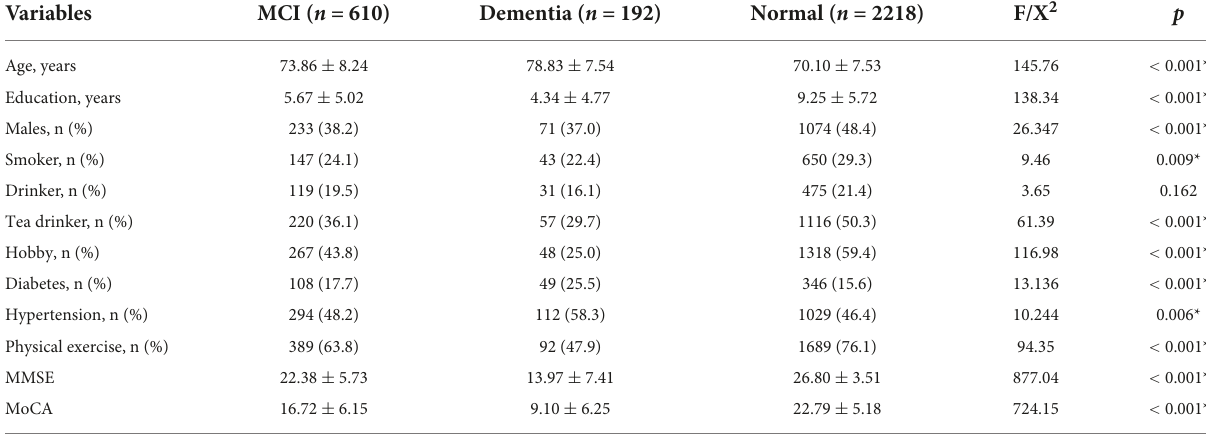
TABLE 1 Demography, life style, physical diseases, and cognitive function in the overall database of study participants.